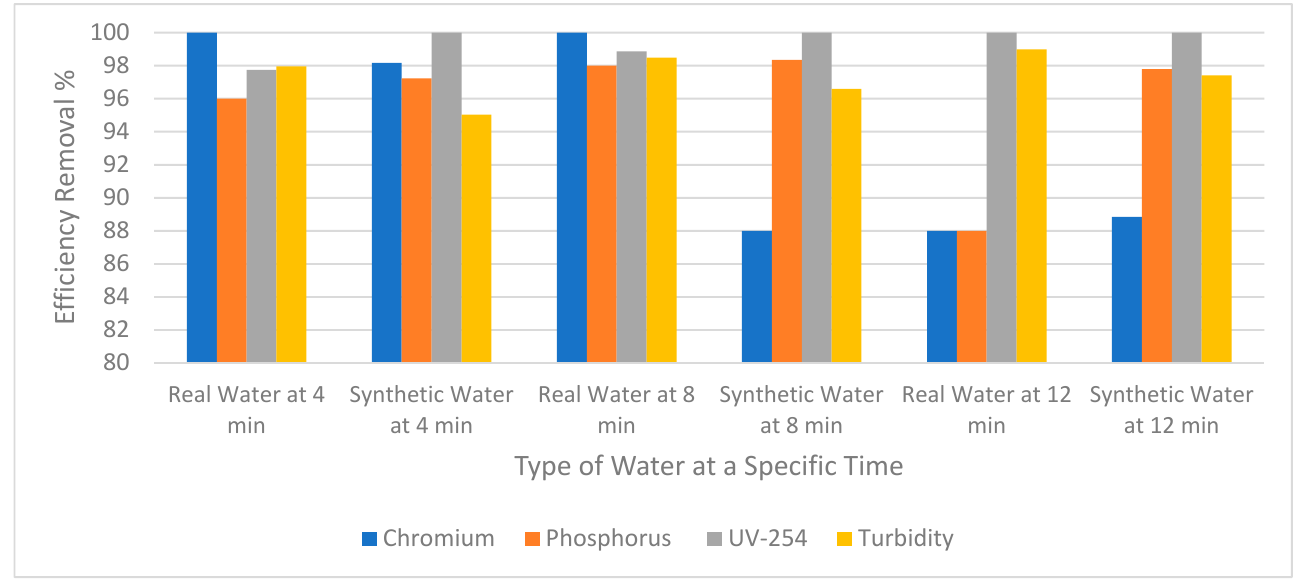
Figure 6. The removal efficiency of pollutants for real wastewater vs synthetic water.